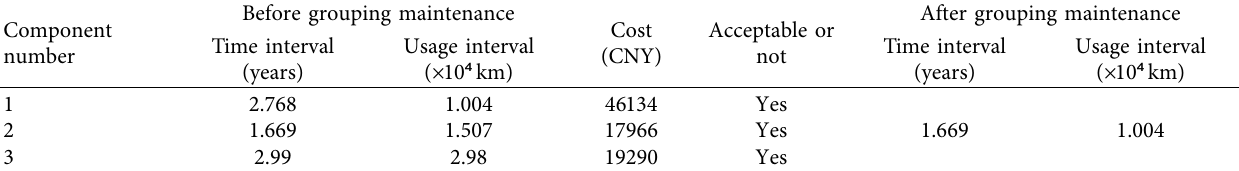
Table 3: Comparison of the availability with PM measures and without PM measures.